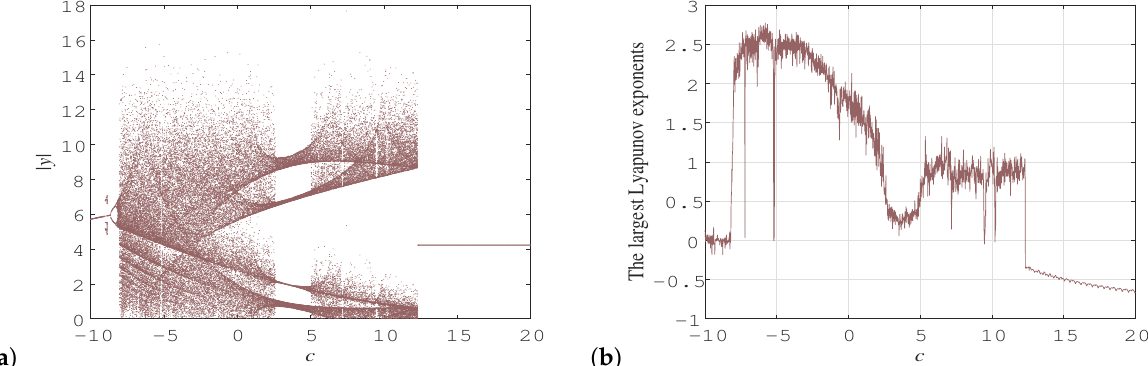
Figure 8. Three-dimensional views of various limit cycles with parameters a = 12, c = 10, and k = 4.6: ( a ) b = 45, ( x 0 , y 0 , z 0 ) = ( 1,1,1 ) , ( b ) b = 47, ( x 0 , y 0 , z 0 ) = ( 1,1,1 ) , ( c ) b = 47,